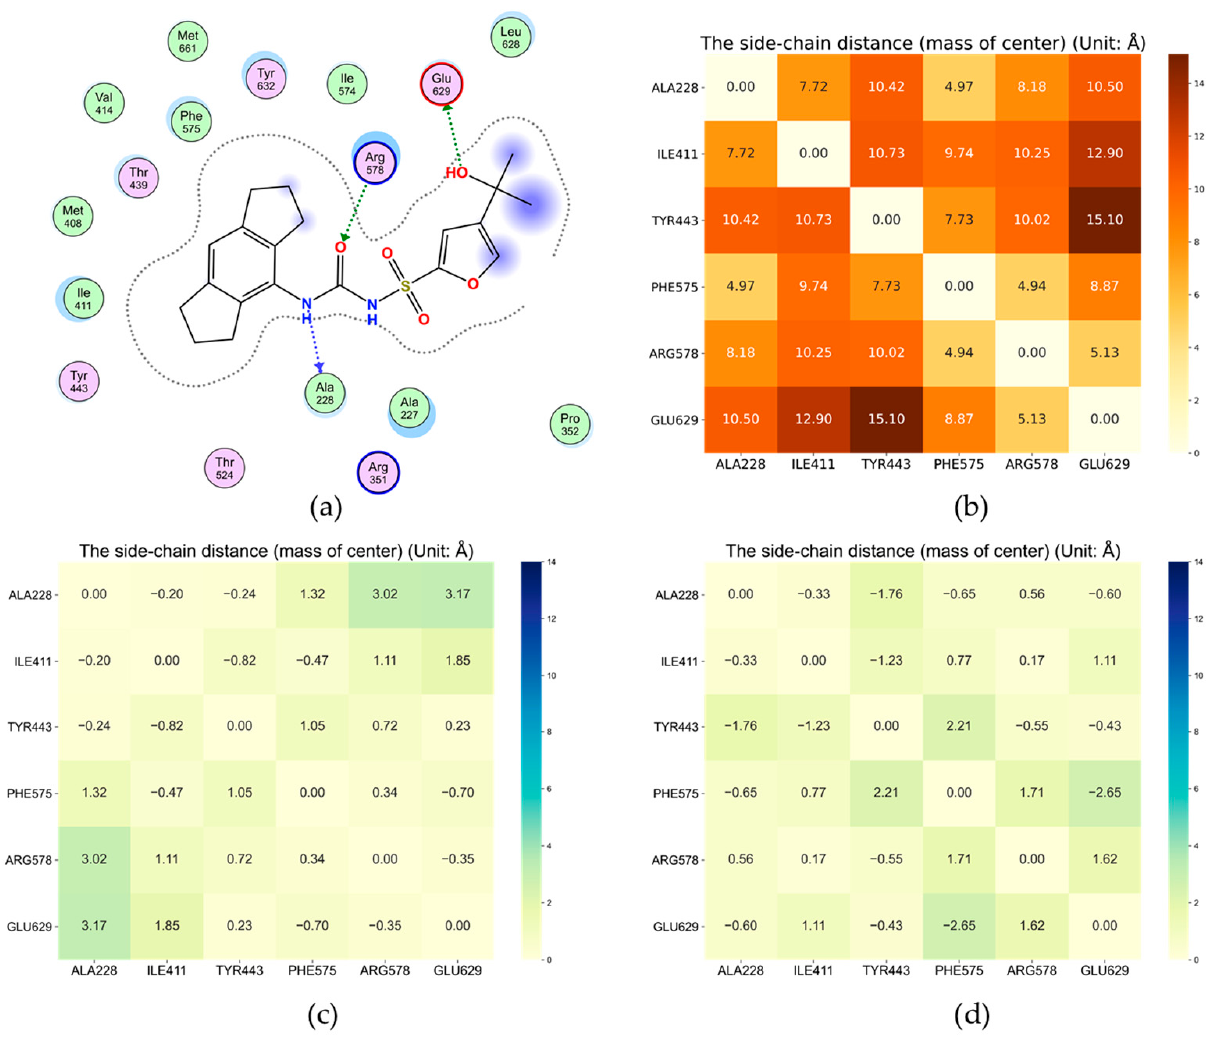
Figure 3. ( a ) Major interactions between MCC950 and NLRP3 in 7PZC; ( b ) side-chain distances between pairs of key residues at the binding site of MCC950 in 7PZC; side-chain distances between pairs of key residues in ( c ) AF model 4 and ( d ) RF model 1 relative to those in 7PZC (unit: Å). The magnitudes of the numbers in ( c , d ) indicate deviations from the experimental structure, and the plus and minus signs indicate larger or smaller distances compared to those in 7PZC.